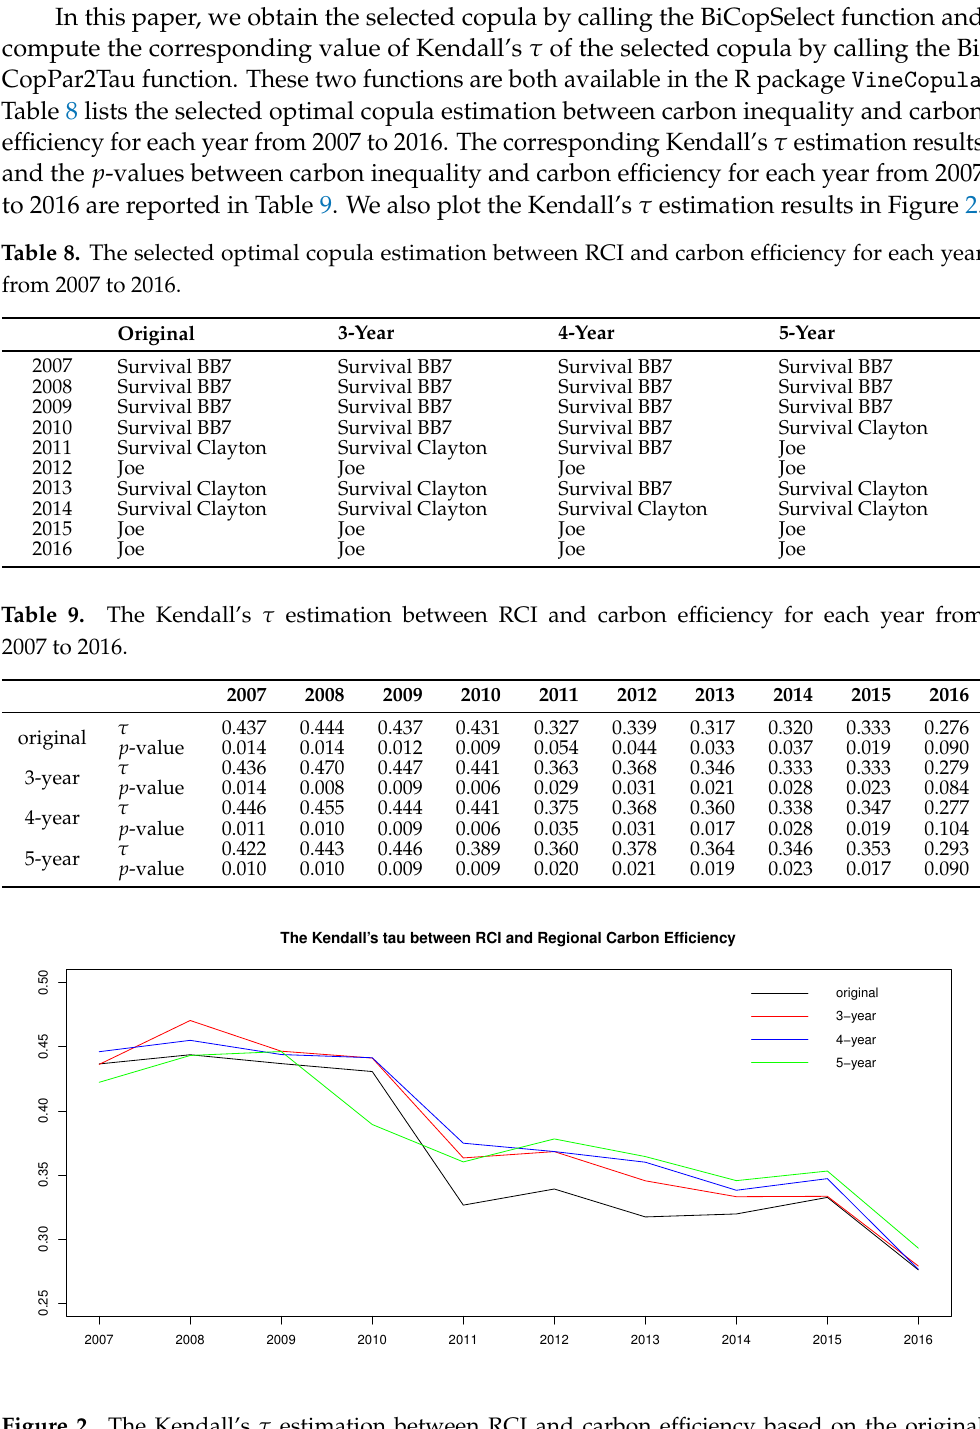
Figure 2. The Kendall’s τ estimation between RCI and carbon efficiency based on the original intra-provincial RCI estimation results and the 3-, 4-, 5-year rolling windows from 2007 to